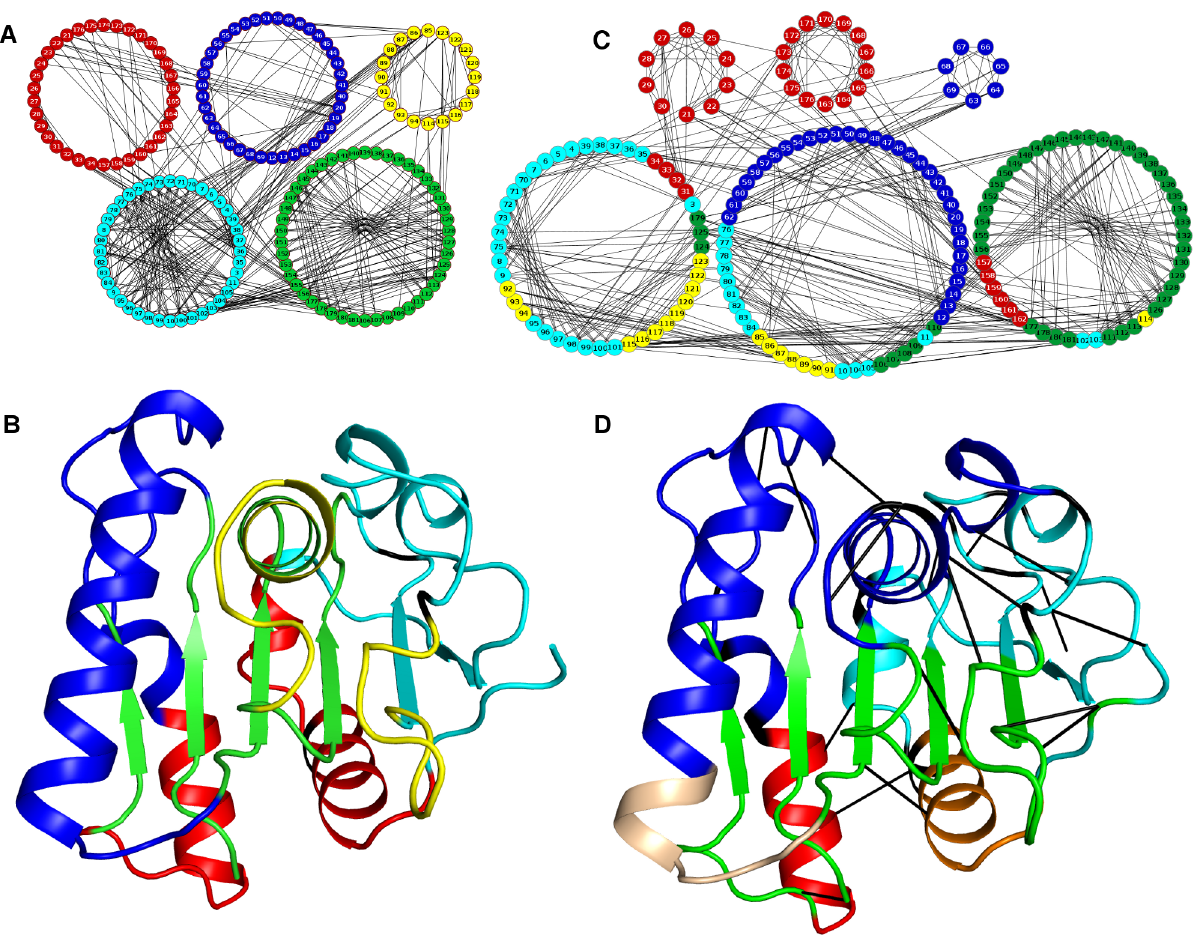
Figure 9. Community structure in the WT and 6B mutant. A) Community structure in WT showing five communities in five different colors. B) Five communities mapped on the tertiary structure of WT. C) Community structure in 6B showing six different communities. The colors of the nodes have been shown according to membership in WT in order to indicate the reorganization of the communities. D) Six communities mapped on the tertiary structure of 6B. The Black lines represent the new contacts made in the 6B as compared to